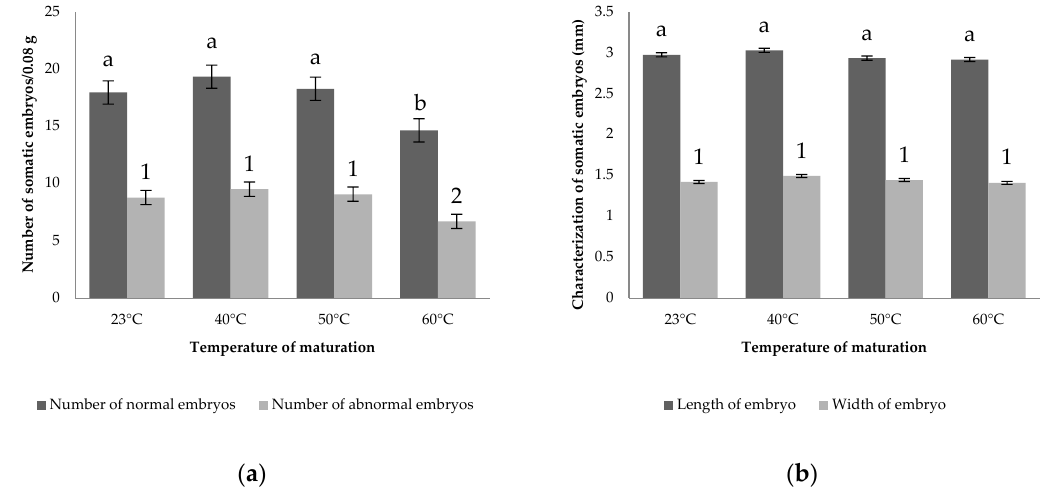
Figure 3. Somatic embryos obtained per 0.08 g of embryonal masses submitted in different maturation temperatures (23, 40, 50, and 60 °C, after 12 weeks, 90, 30, 5 min, respectively). ( a ) Number of normal and abnormal somatic embryos; ( b ) the length and width of Pinus radiata D.Don normal embryos. Different letters or numbers show significant differences by the Tukey–Kramer test ( p ≤ 0.05).